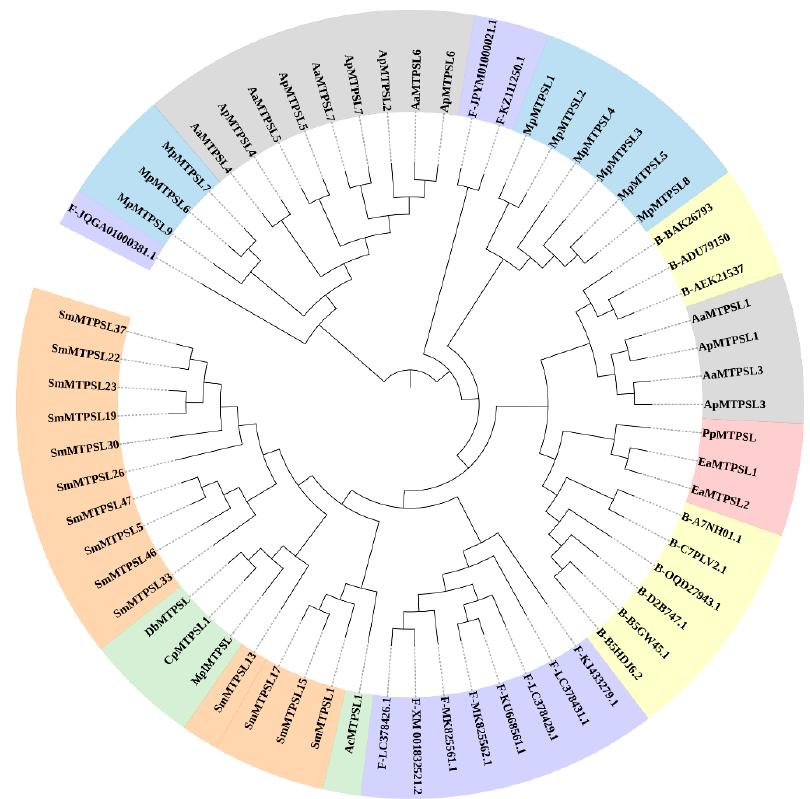
Figure 2. Phylogenetic tree of terpene synthase (TPSs) sequences. Sequences included are MTPSLs from S. moellendorffii (orange), ferns (green), red algae (pink), hornworts (gray), and liverworts (blue), and TPSs from fungi (purple) and bacteria (yellow). The tree was constructed with the maximum likelihood method and 1000 replications for bootstrapping. Bootstrap values are not drawn on any nodes with a value less than 70%. A list of genes GenBank accession numbers are given in Table S2.